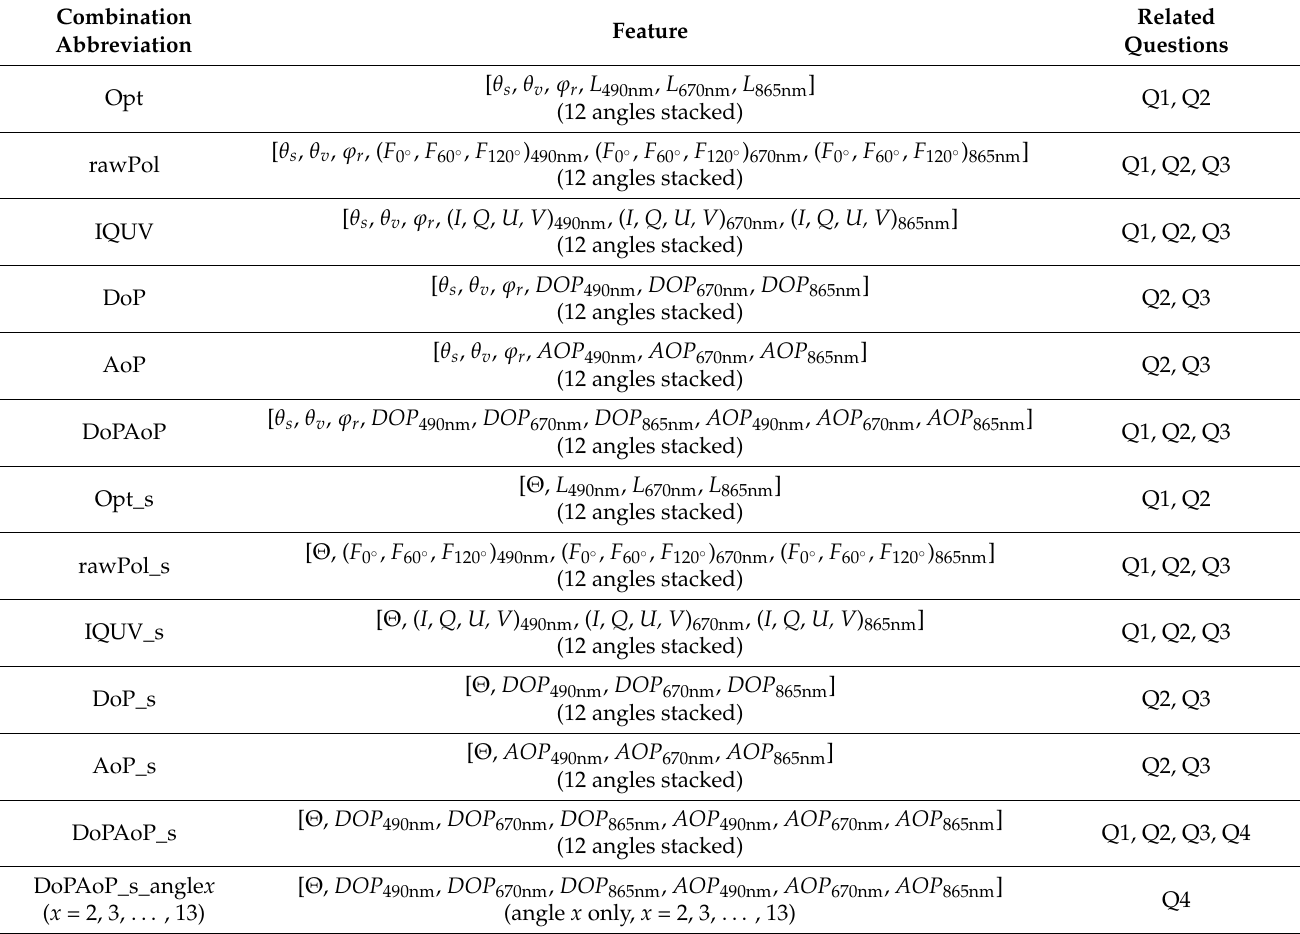
Table 3. Different combinations tested in random forest